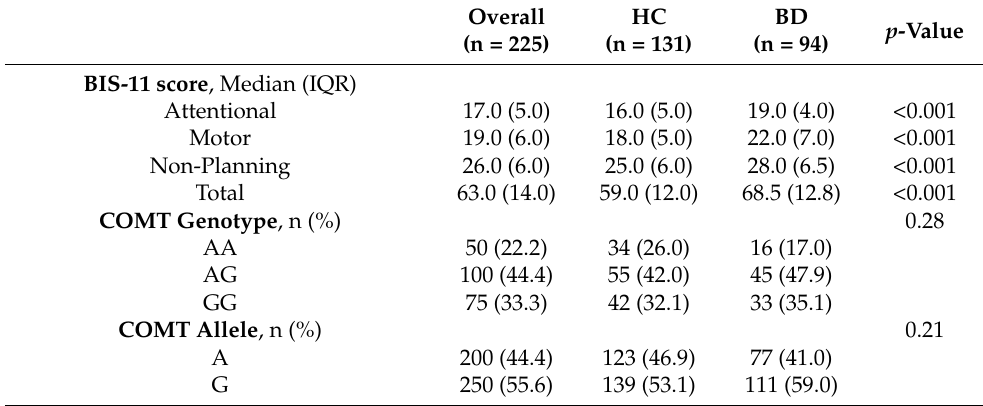
Figure 2. BIS-11 score (Attentional, Motor, Non-Planning and Total) by 5-HTTLPR polymorphisms for HC and BD. Table 2. BIS-11 scores and polymorphism distribution by case-control status variable.